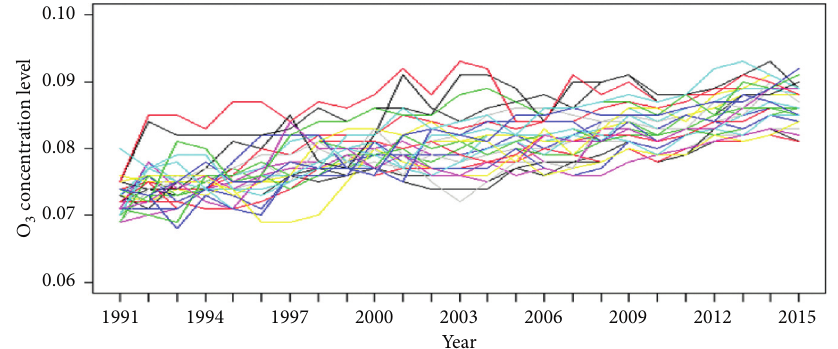
Figure 3: Time series plots of ozone concentration levels in the 29 air monitoring sites in South